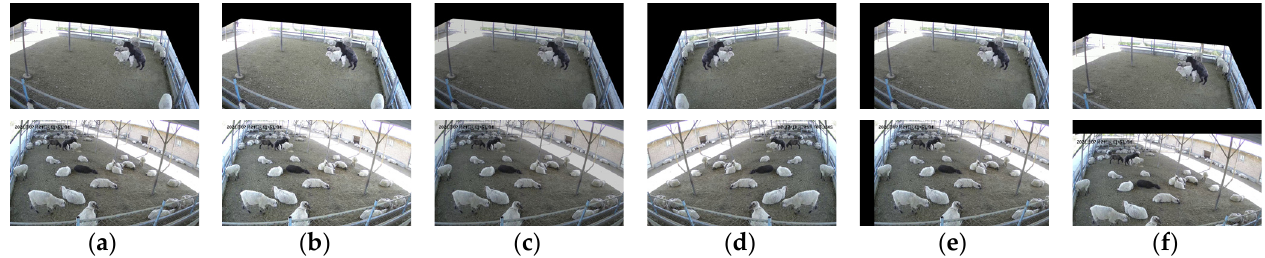
Figure 3. Data enhancement processing: ( a ) Original picture; ( b ) Brightness enhancement; ( c ) Brightness reduction; ( d ) Flip horizontally; ( e ) Horizontal movement; ( f ) Vertical movement. The Chinese characters in the upper left corner of the image are the date of the video recording, in order of year, month, and day.